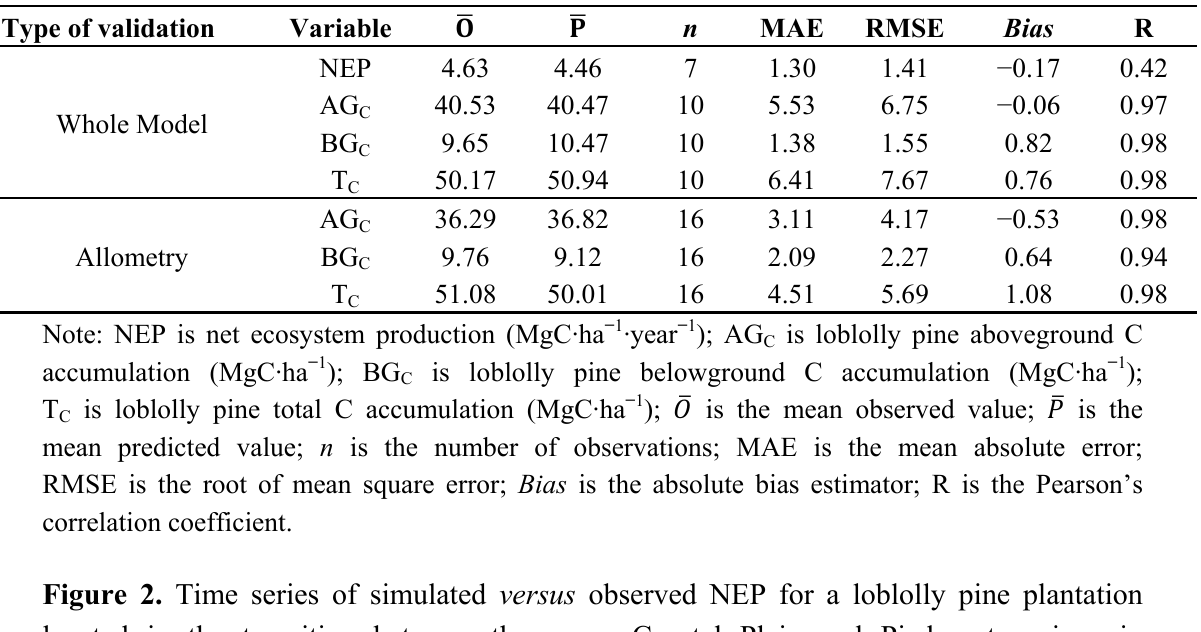
Table 5. Summary of model evaluation statistics.